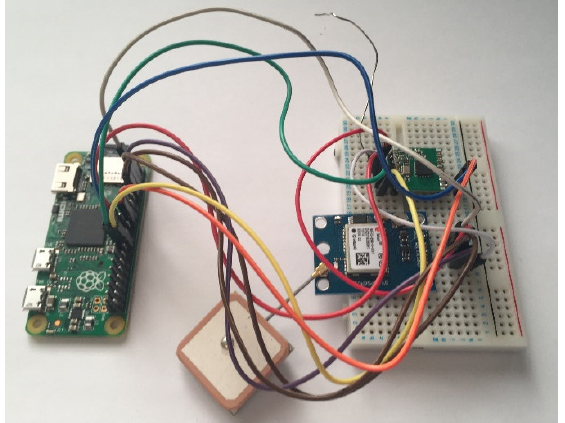
Figure 16. Photo showing the final vehicle tracking node.